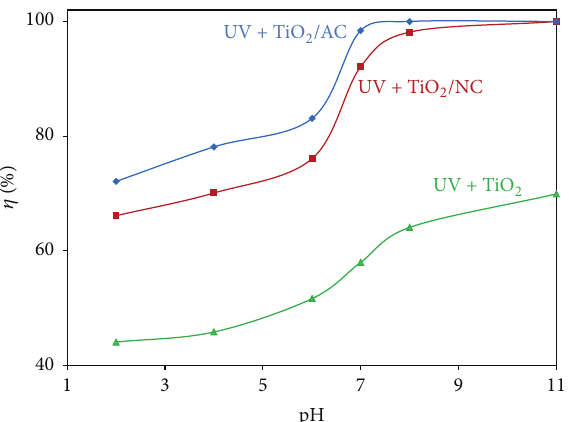
Figure 6: Effect of catalyst loading on photocatalytic degradation of MGusingTiO 2 (P25),TiO 2 /NC,andTiO 2 /AC(initialconcentration of MG = 75 mg/L and irradiation time = 180min at pH =